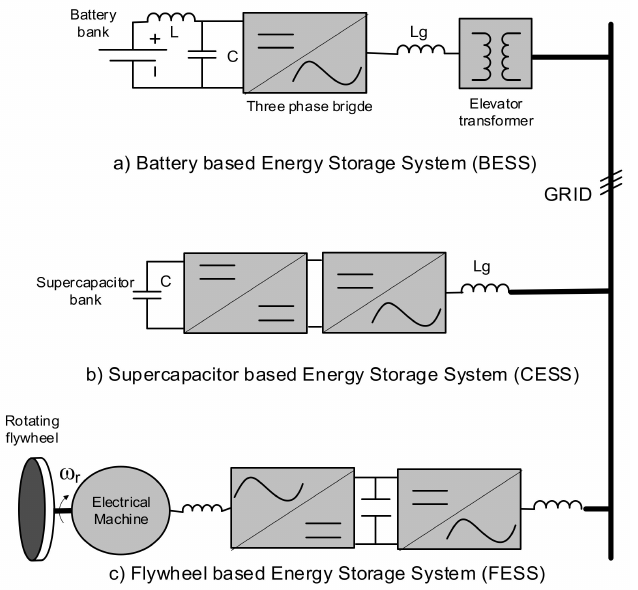
Figure 4. Structures of energy storage systems (ESSs) based on ( a ) batteries (BESSs), ( b ) supercapaci- tors (CESSs) and ( c ) flywheels